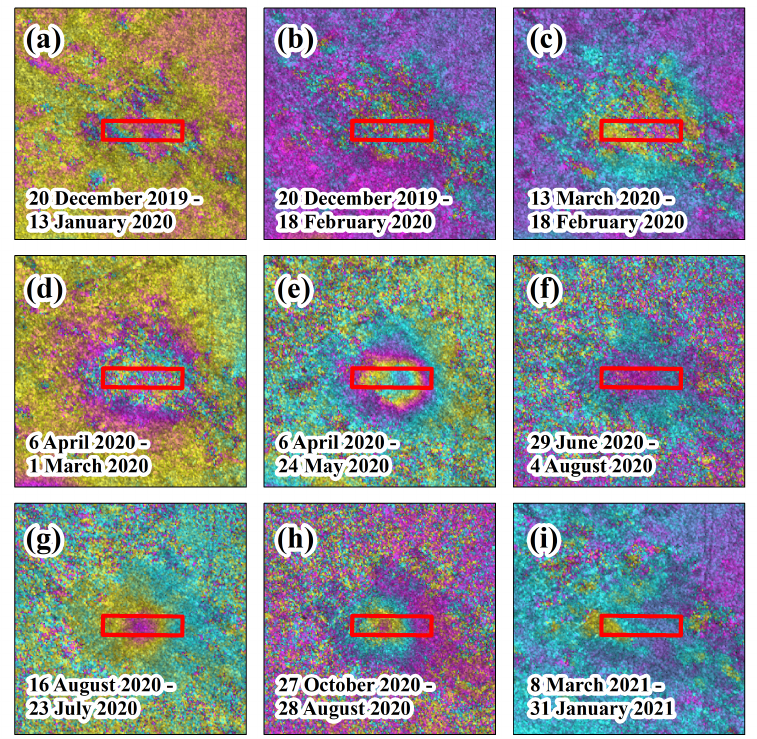
Figure 7. Interference images. Subfigures ( a – i ) are the interference images corresponding to the image pairs in Table 3. The layout of the 2401 working face is marked by the red rectangle.